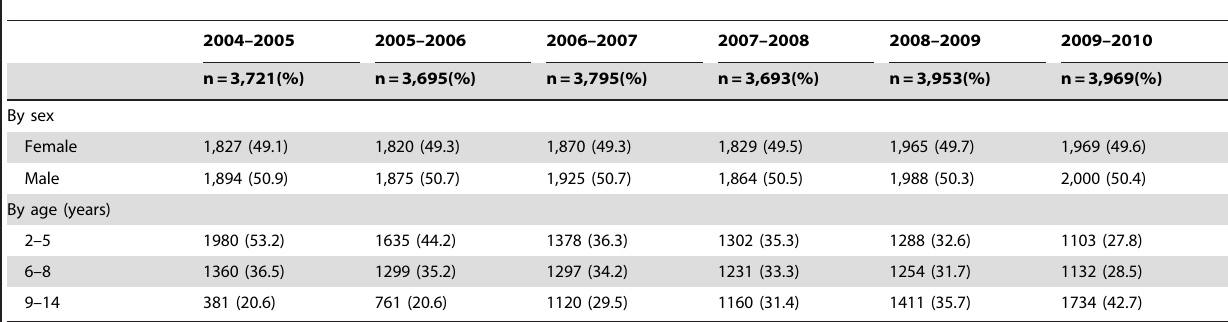
Table 1. Participant characteristics by year, Managua, Nicaragua,